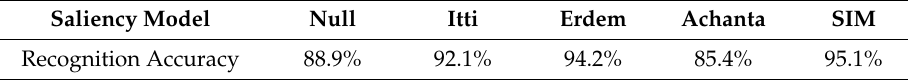
Table 2. Influence of saliency models on recognition accuracy.